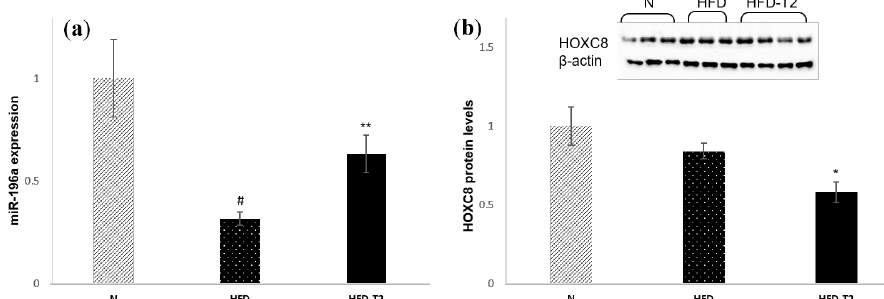
Figure 7. qPCR analysis of miR-196a in sWAT of N, HFD, and HFD-T 2 rats. ( a ) qPCR analysis of miR-196a in sWAT of N, HFD, and HFD-T 2 rats; ( b ) Immunoblots and densitometry showing relative expression of HOXC8 and β -actin in sWAT lysates. Values are means ± SEM of five independent experiments ( N = 5), * p < 0.05 vs. N-HFD; ** p < 0.05 vs. HFD # p < 0.05 vs. N. 3.6. T 2 Administration Reduces the Phosphorylation of an Important Regulator of Browning: MAPK Kinase 6